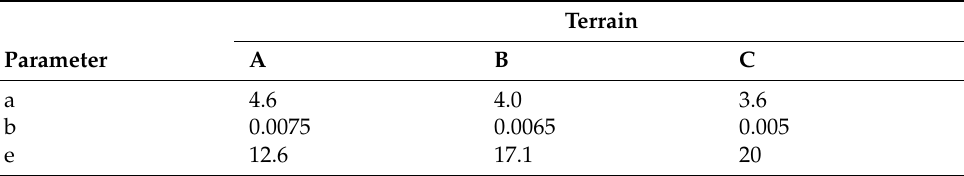
Table 9. Parameters for different type of terrains for SUI model